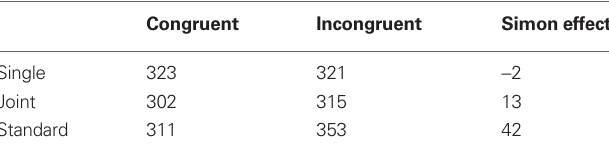
Table 1 | experiment 1, mean rTs and Simon effect for the three conditions.